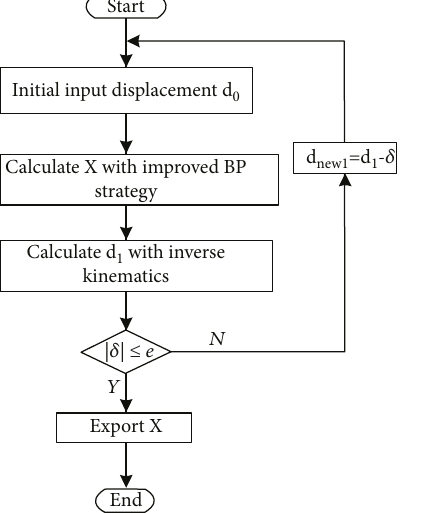
Figure 5: Flowchart of the position Table 3: Forward kinematics results of the parallel manipulator by utilizing the BP neural network with position compensation.